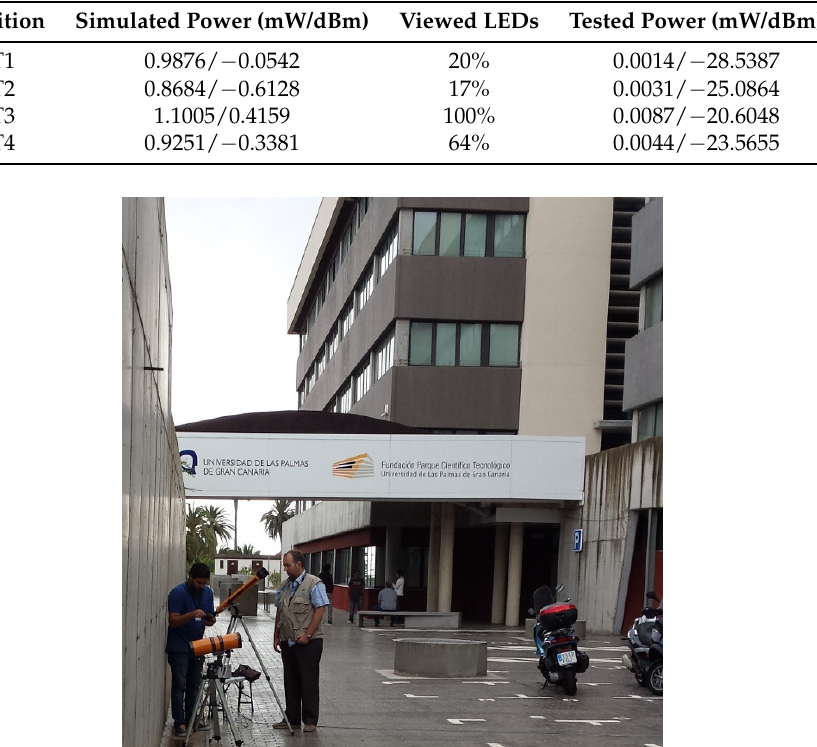
Figure 6. Assembly used to eavesdrop on the VLC channel from position T1.